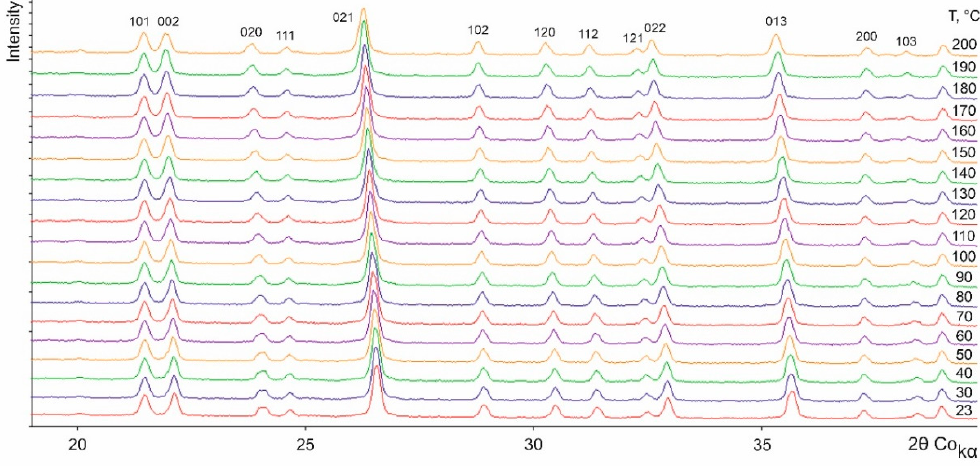
Figure 6. X-ray patterns (2 θ Co K α ) of an L-ser sample obtained at various temperatures.